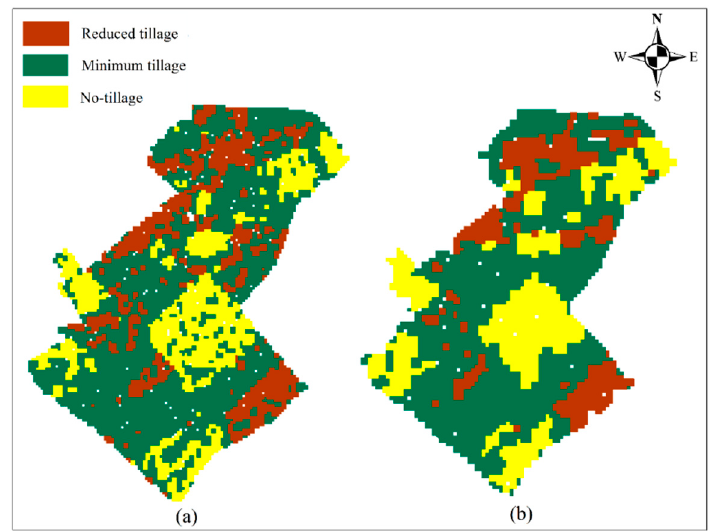
Figure 8. SSR maps using membership function classification: ( a ) Sentinel-2A image, ( b ) Landsat-8 image.